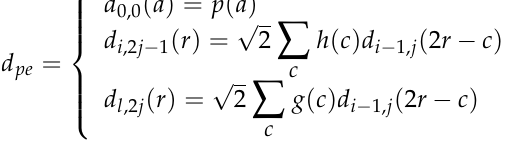
Figure 7. Wavelet packet entropy (two ‐ level) decomposition for the inertial data (for walking data from the USC ‐ HAD dataset).